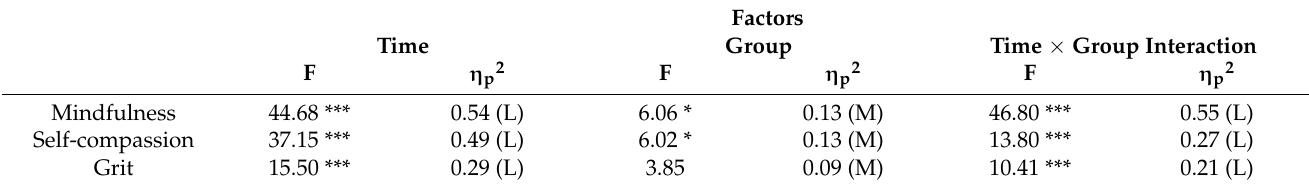
Table 4. Inferential statistics for outcome variables at baseline, at post-intervention and at follow-up, separately for participants in the MAC = Mindfulness–Acceptance–Commitment (MAC) and the active control condition.